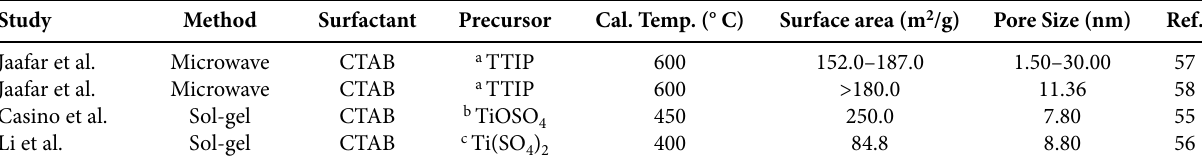
Table 1. Summary of preparation methods using cationic surfactants as SDA.